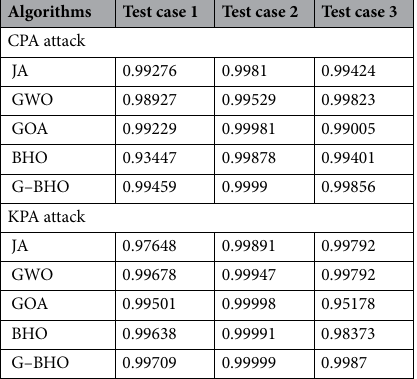
Table 2. Performance analysis on privacy preservation model in industrial IoT for three test cases in terms of CPA and KPA